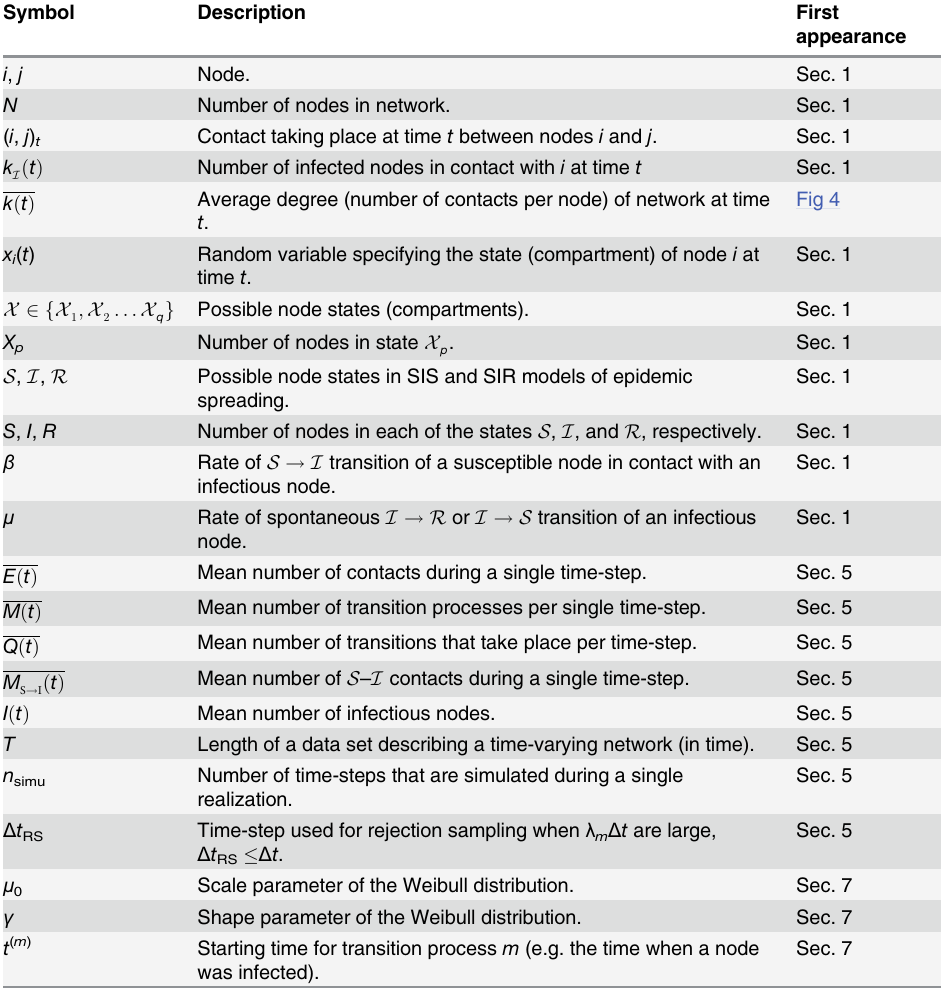
Starting time for transition process m (e.g. the time when a node was infected).